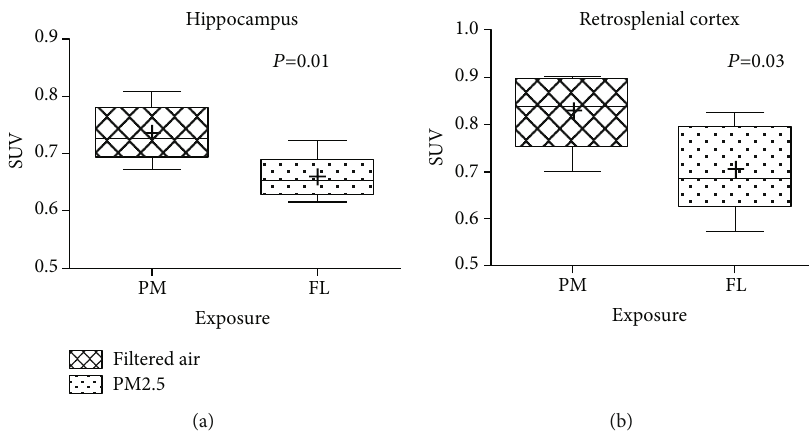
Figure 3: Tracer distribution of the [ 18 F]FEPPA (2) in the hippocampus (a) and retrosplenial region (b) of the temporal lobes.